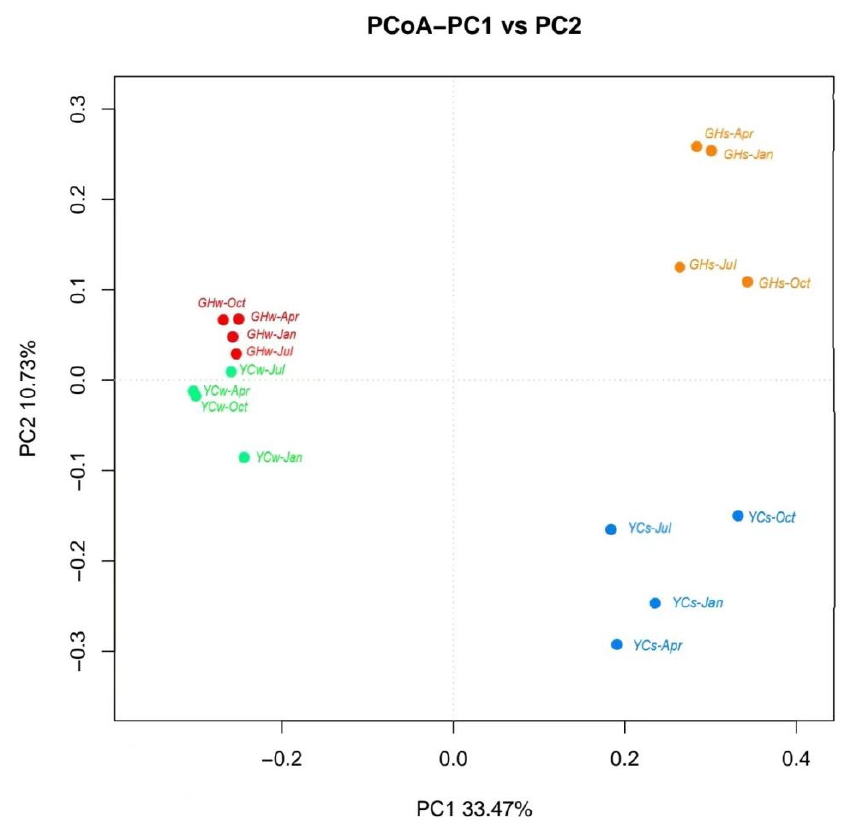
Figure 3. Principal coordinate analysis (PCoA) based on the unweighted uniFrac profile demonstrated the dissimilarities in the microbial community composition of the different samples. [Note: PC1 and PC2 contributes of 33.47% and 10.73%, respectively.] Each point in the figure represents a sample; red and orange dots represent water and mud samples from site GH while green and blue dots represent water and mud samples from site YC, respectively.